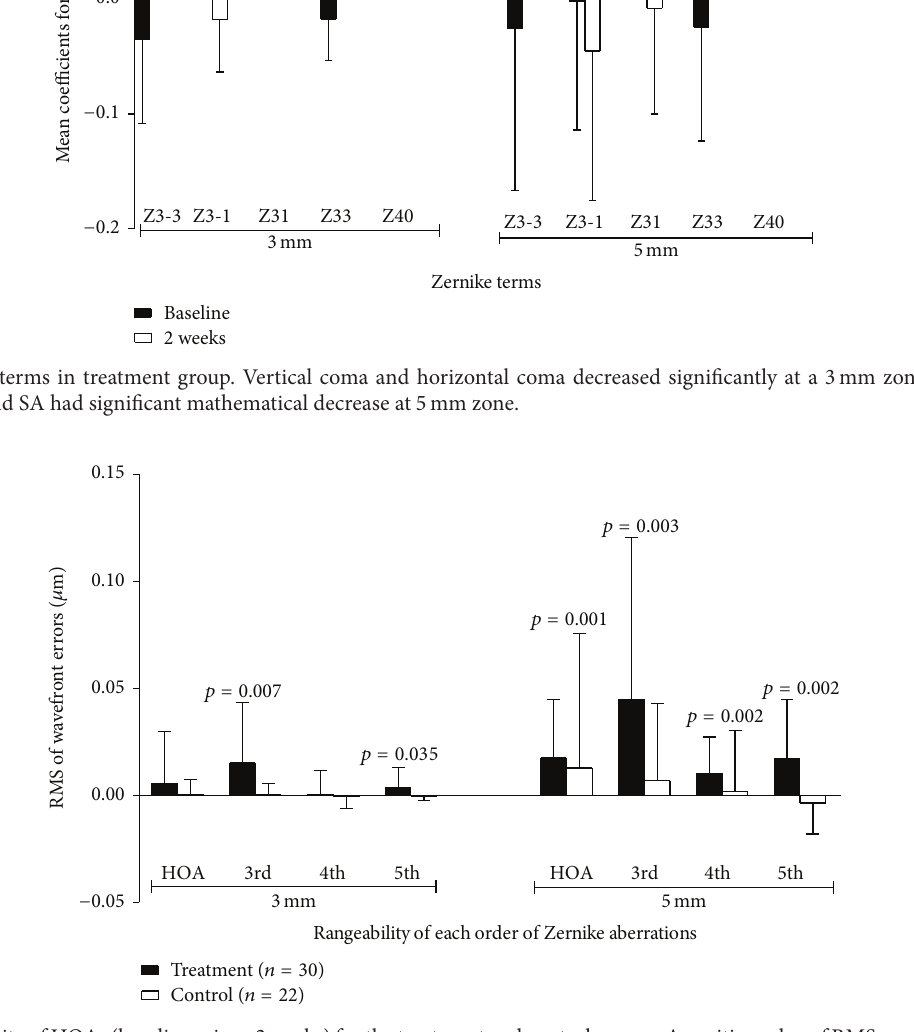
Figure 5: Rangeability of HOAs (baseline minus 2 weeks) for the treatment and control groups. A positive value of RMS rangeability indicates a decreasing of HOAs amplitude after treatment, and vice versa. For 3mm zone, the 3rd and 5th HOAs decreased significantly after two weeks of artificial tears eye drops treatment. For 5 mm zone, the 3rd, 4th, 5th, and total HOAs all showed a significant decrease after 2 weeks of